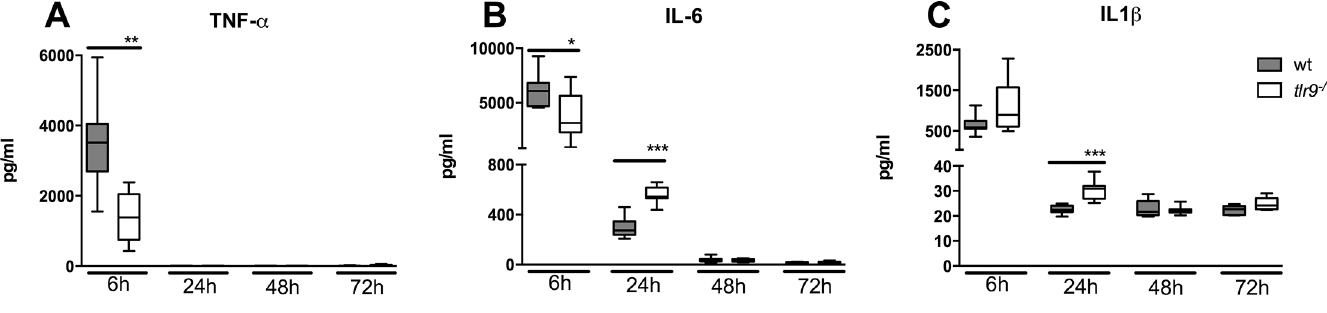
Figure 3. The early cytokine response to S . aureus is reduced in the airways of tlr9 –/– mice. (A–C) Cytokine (TNF- α , IL-6 and IL-1 β ) levels in BALF at different time points after intranasal infection of 1 × 10 7 CFU S . aureus in Wt mice (gray) and tlr9 –/– mice (white). Data are expressed as box-and-whisker diagrams depicting the median, the smallest observation, lower quartile, median, upper quartile and largest observation ( n = 7–8 mice per group at each time point). * p < 0.05, ** p < 0.01 versus Wt mice at the same time point.